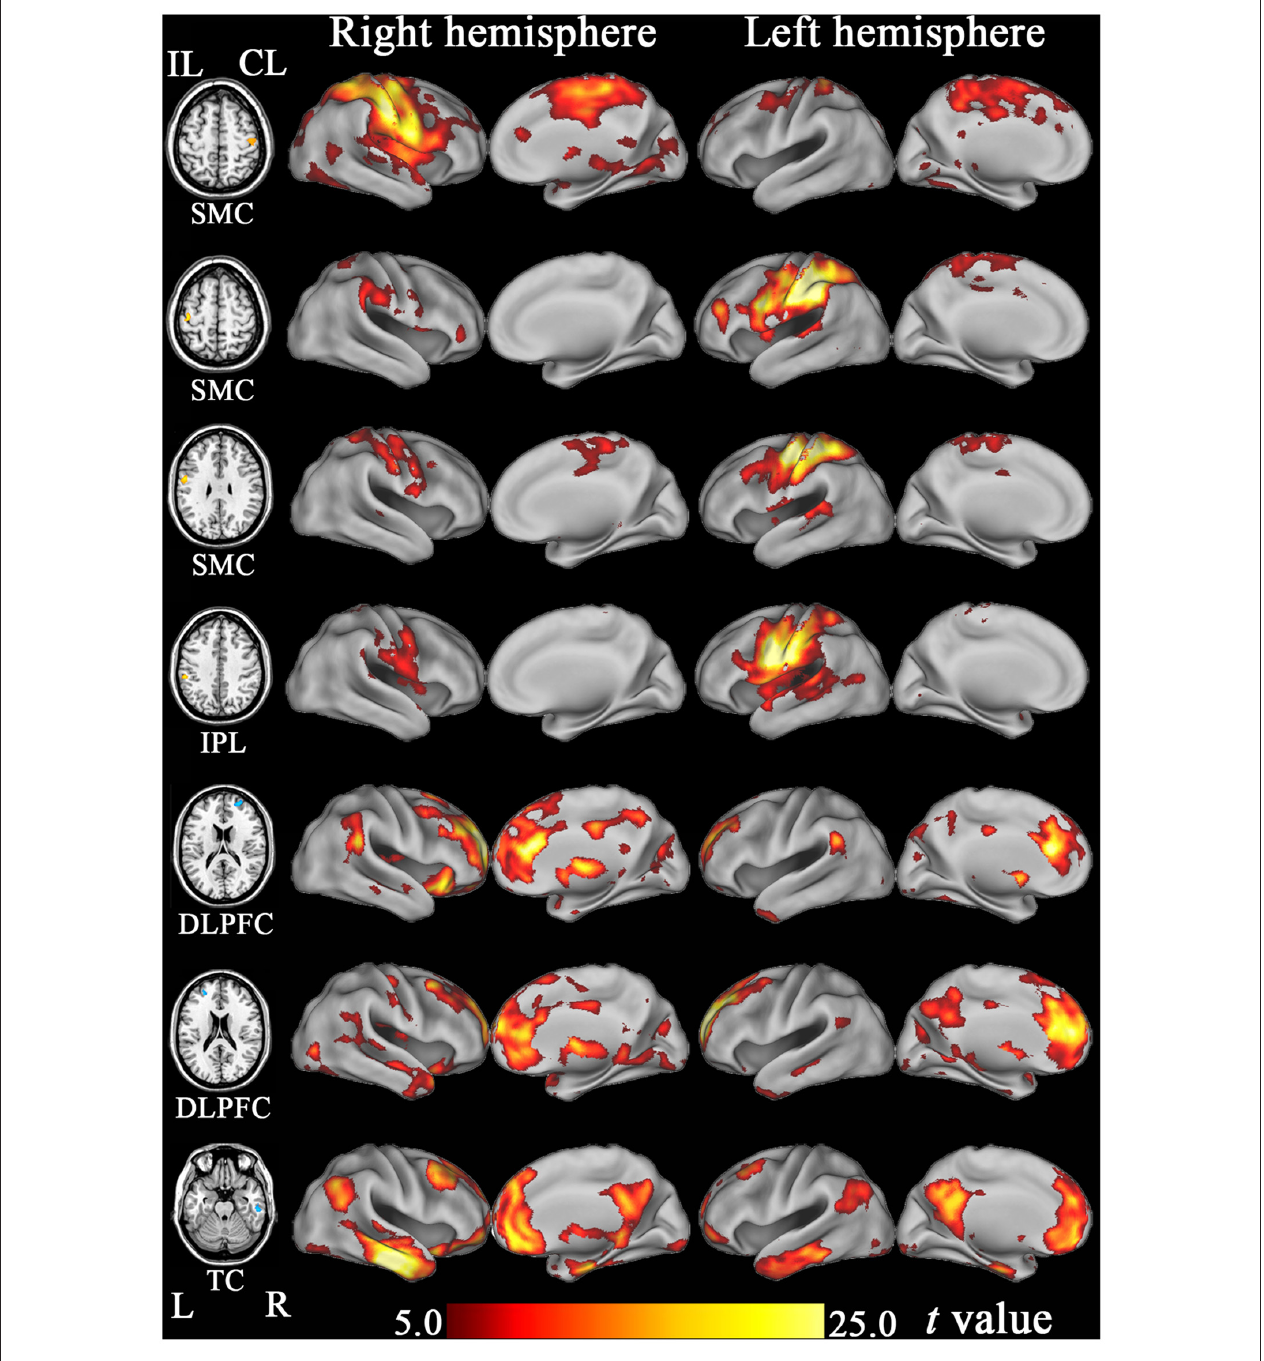
FIGURE 7 | The resting-state functional connectivity maps of hub regions that show significant FCD changes after stroke . DLPFC, dorsolateral prefrontal cortex; FCD, functional connectivity density; IPL, inferior parietal lobule; ITC, inferior temporal cortex; SMC, sensorimotor cortex; TC, temporal